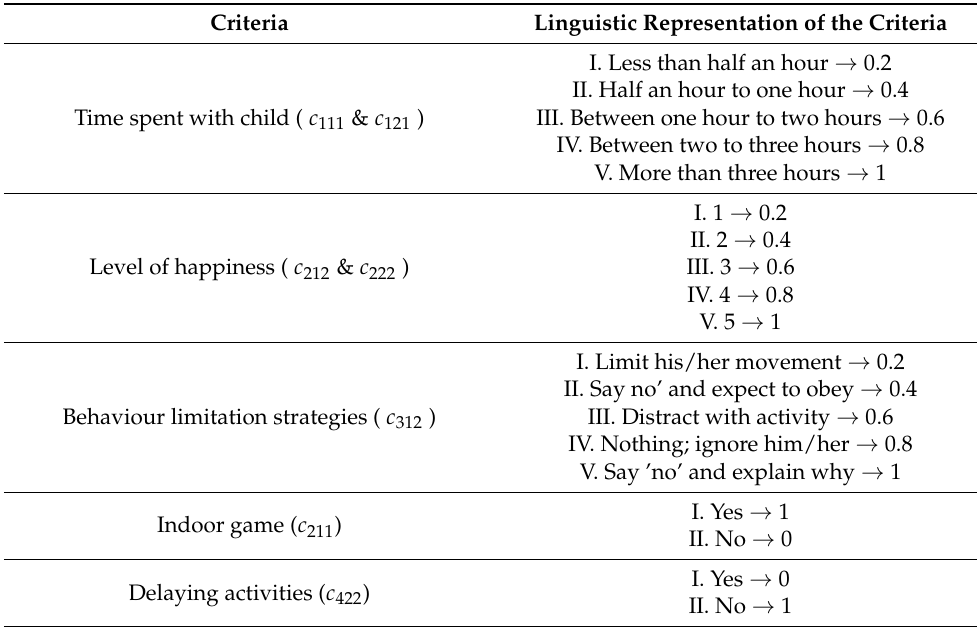
Figure 3. Hierarchical structure of the criteria set. Table 2. Transformation of the crisp linguistic variable into a fuzzy